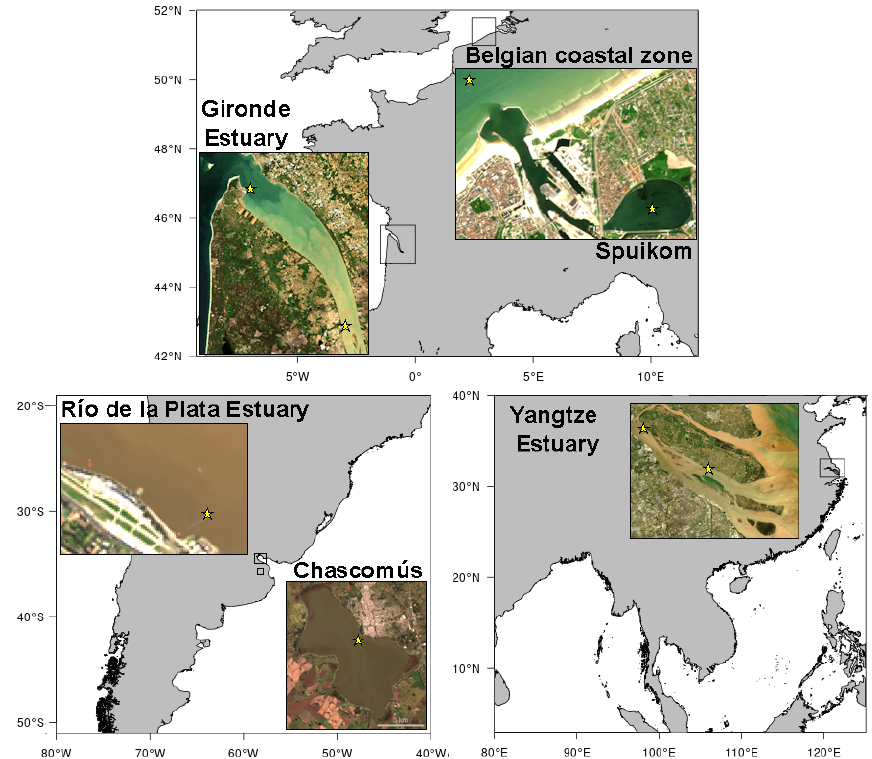
Figure 1. Locations of the study areas. Satellite images come from Landsat 8 OLI (Yangtze: image taken on 29 April 2021, Chascomùs: image taken on 10 May 2017, Rio de la Plata: image taken on 13 August 2014) and Sentinel 2B MSI (Belgian coastal zone: image taken on 30 May 2021, Gironde: image taken on 3 May 2021).